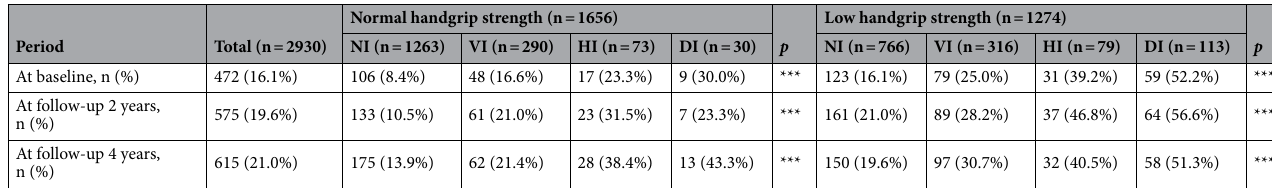
Table 2. The prevalence of cognitive impairment stratified by handgrip strength status and type of sensory impairment by follow-up period. Analyzed using available data, including missing data. P value for the Pearson chi-square test for group comparisons of types of sensory impairment within each group of handgrip strength. DI dual sensory impairment, HI hearing impairment only, NI no sensory impairment, VI vision